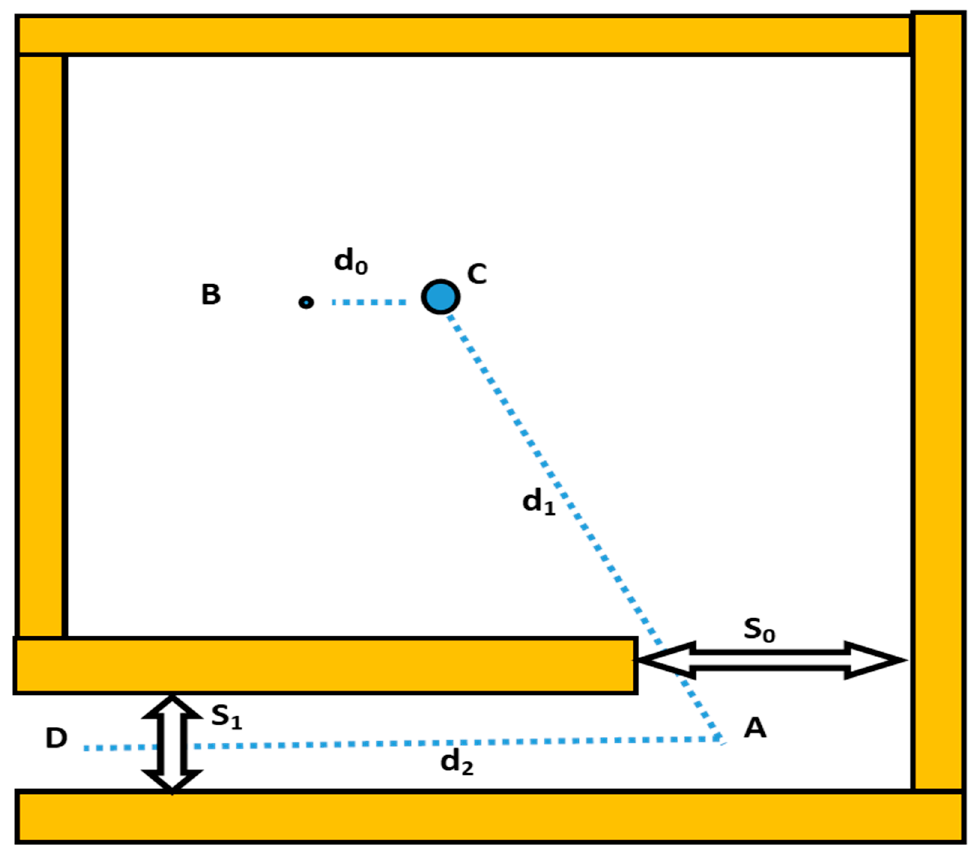
Figure 1. Diagram showing linac vault geometry definitions used for dose calculations. (The point B is at a distance of 1.41 m from the isocenter; d 1 represents the distance between the isocenter (C) and the just-visible point (A) on the maze centerline; d 2 is the distance between point A and maze entrance D, where S0 and S1 denote the inner and outer maze entrance cross-sectional areas, respec- tively).